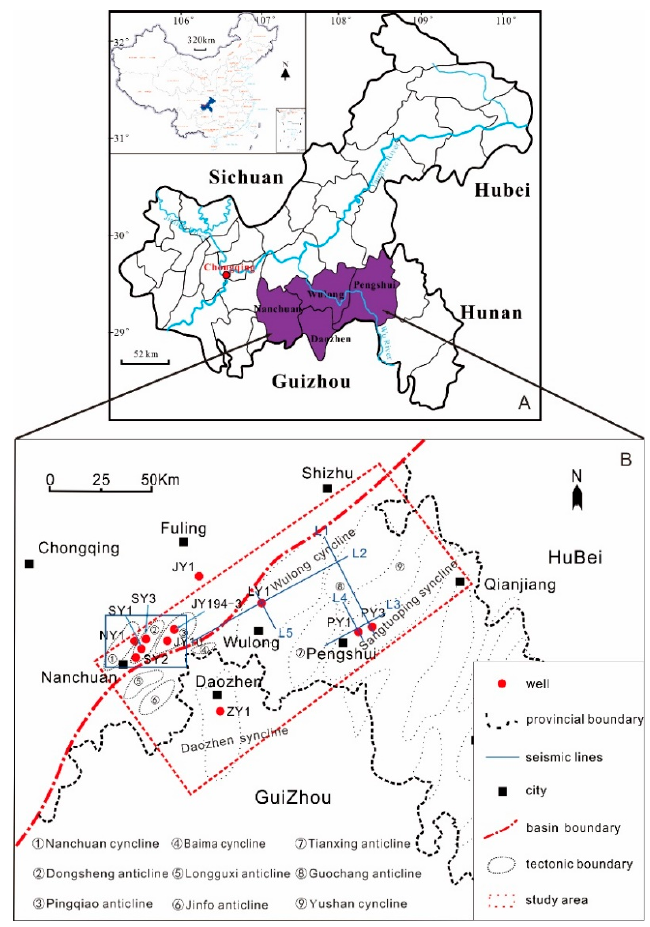
Figure 1. Geographical location of basin margin transition zone in the study area.